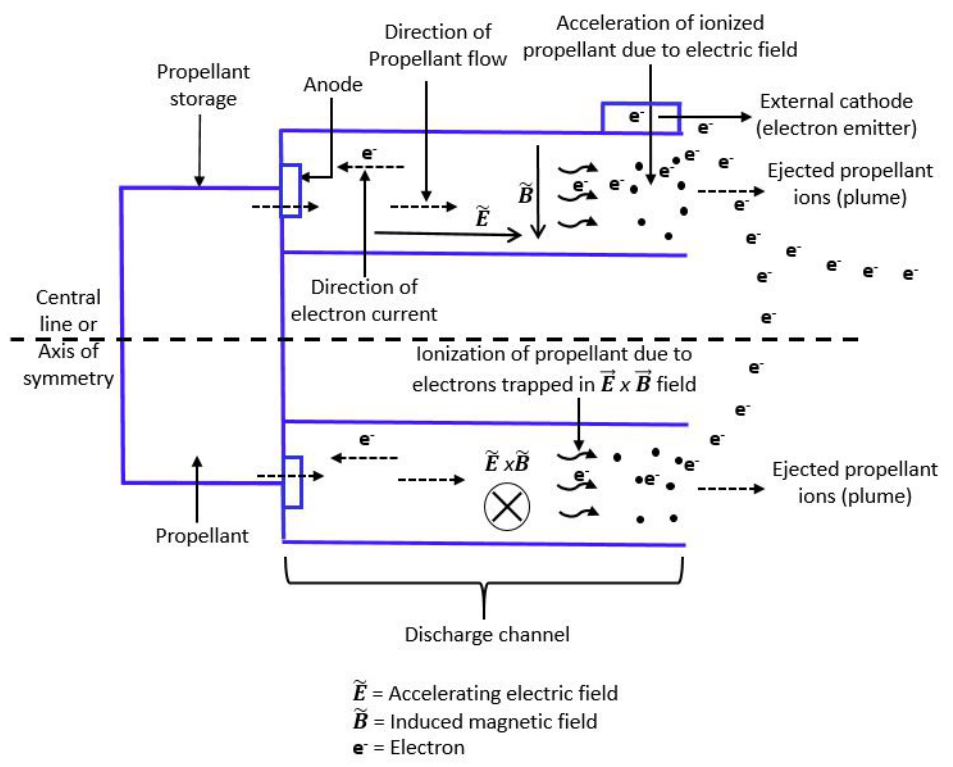
Figure 6. Schematic of a Hall Effect Propulsion